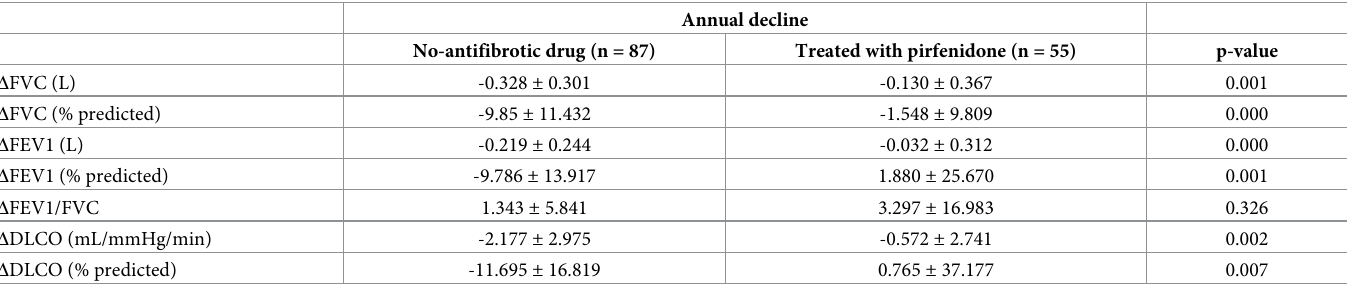
Table 4. Comparison of pirfenidone treatment and annual decline in pulmonary